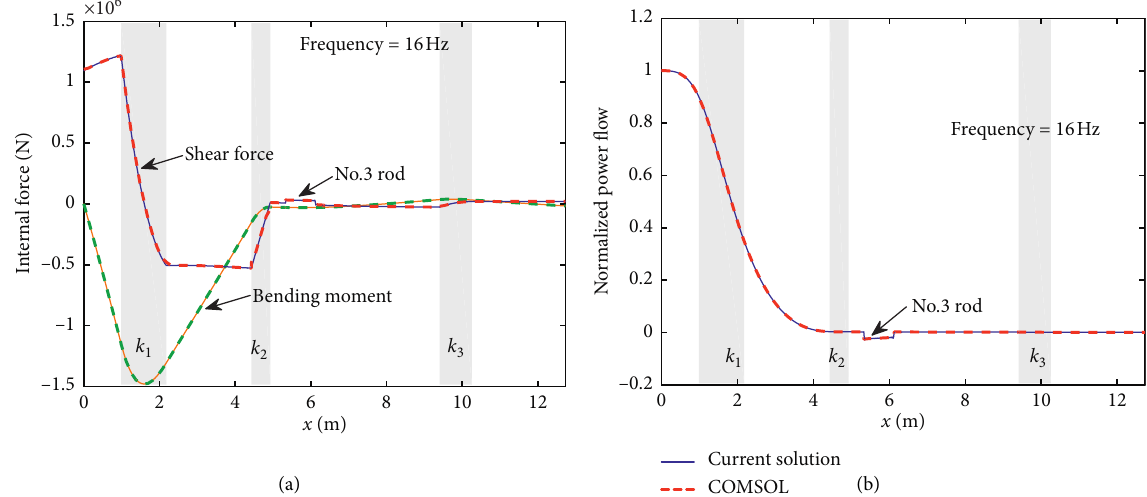
Figure 7: Comparison of power flow analysis made by current solution and COMSOL. (a) Internal force; (b) normalized power flow.